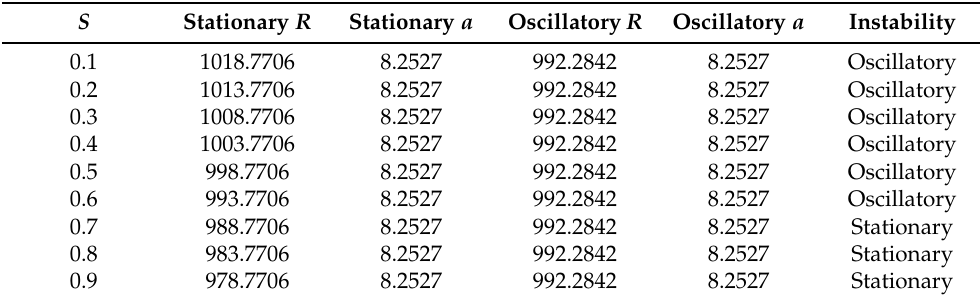
Table 2. Critical stationary and oscillatory Rayleigh numbers for the different values of S and the fixed values of κ r = 1, Ta = 50, and Rc = 50.